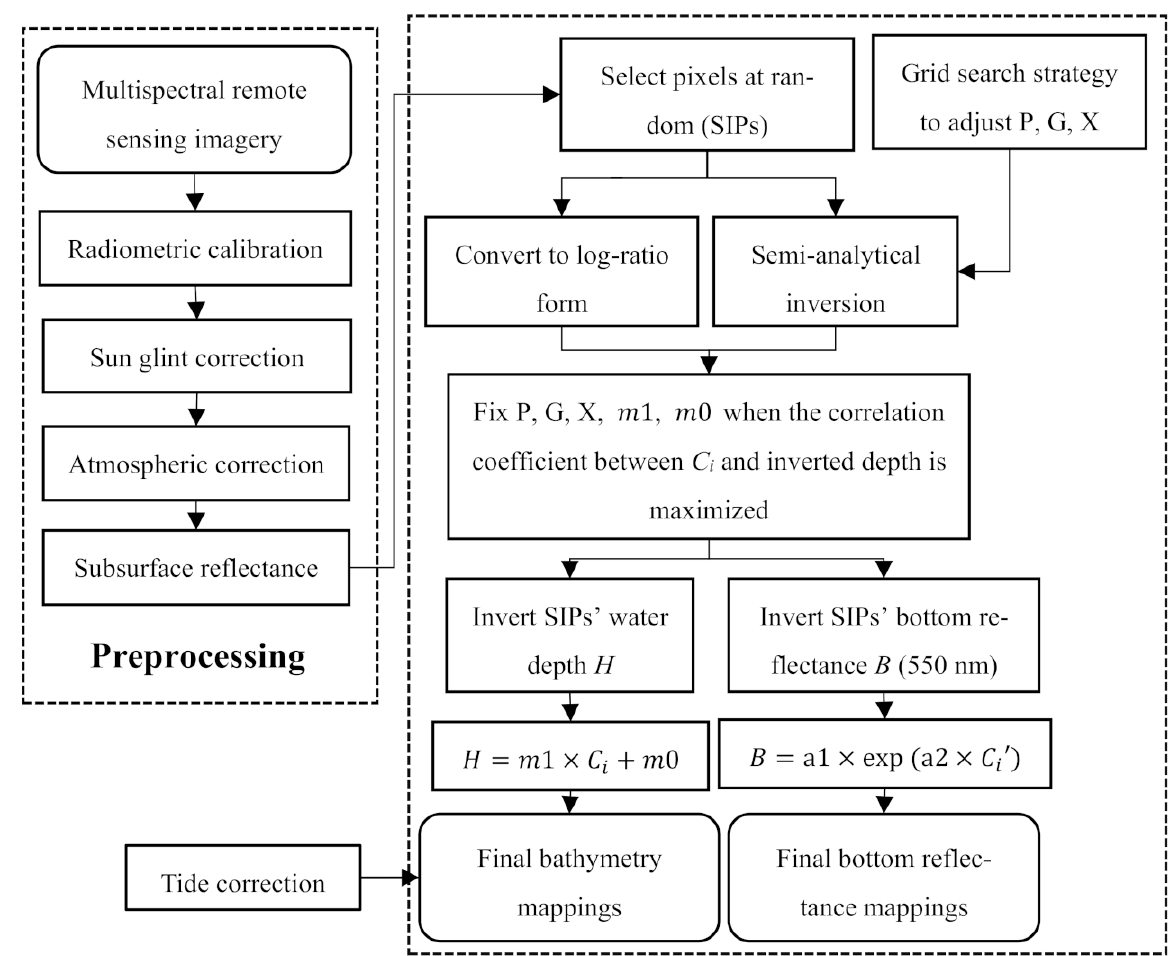
Figure 4. Workflow of the Log-transformed ratio and Semi-analytical (LR-S)